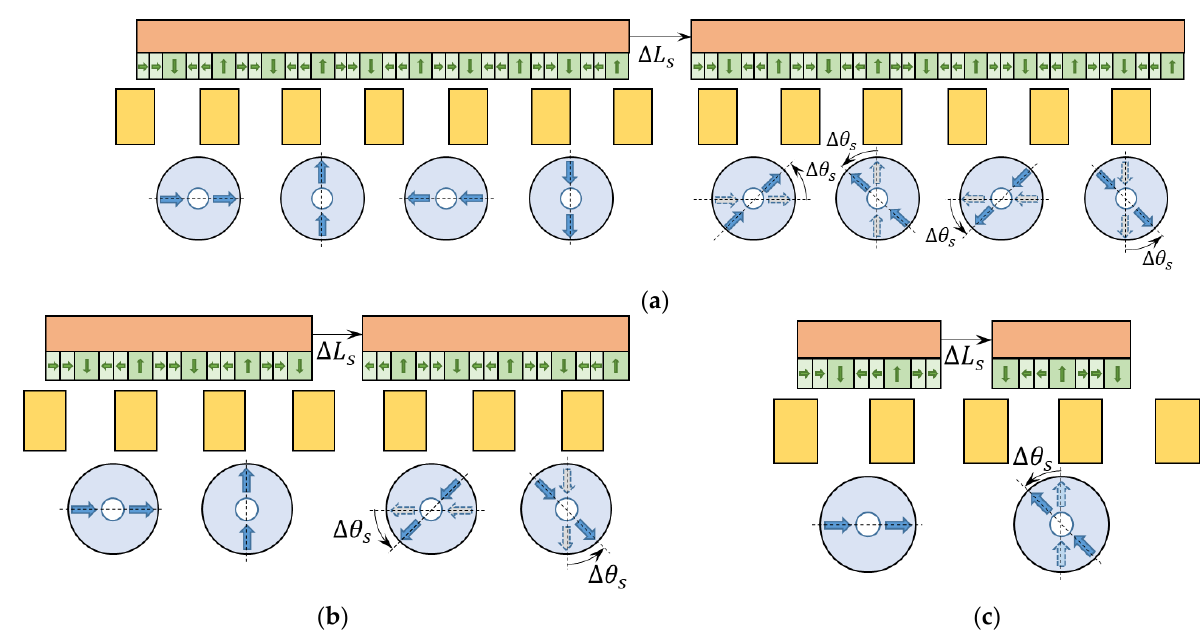
Figure 5. RPMC modules with quasi-Halbach magnetization; ∆ L s : shifting distance between adjacent modules ( ∆ θ s corresponding angular shift of the magnetization); ( a ) n c = 4 (conf. A); ( b ) n c = 2 (conf. B); ( c ) n c = 1 (conf. C).